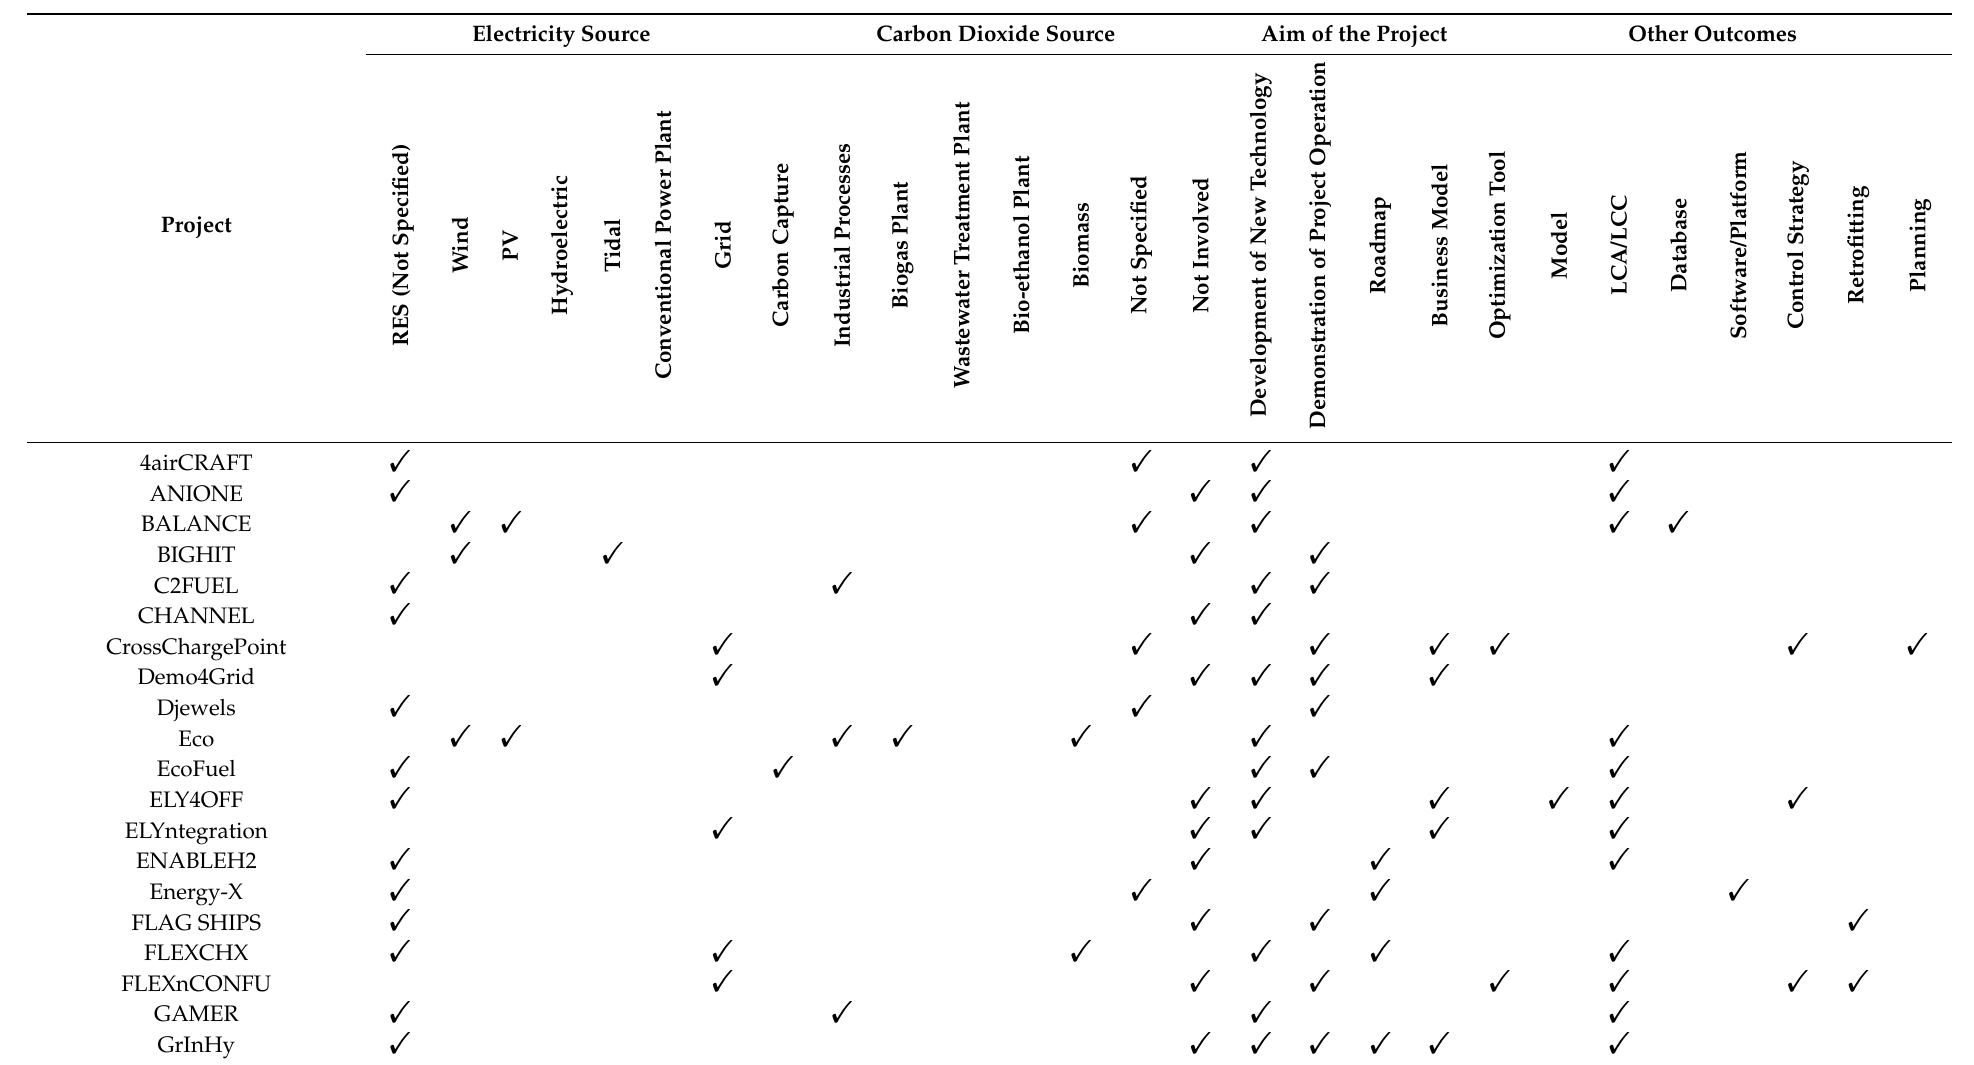
Table A3. Relevant features of the selected projects: electricity source, carbon dioxide source, aim of the project and other outcomes.